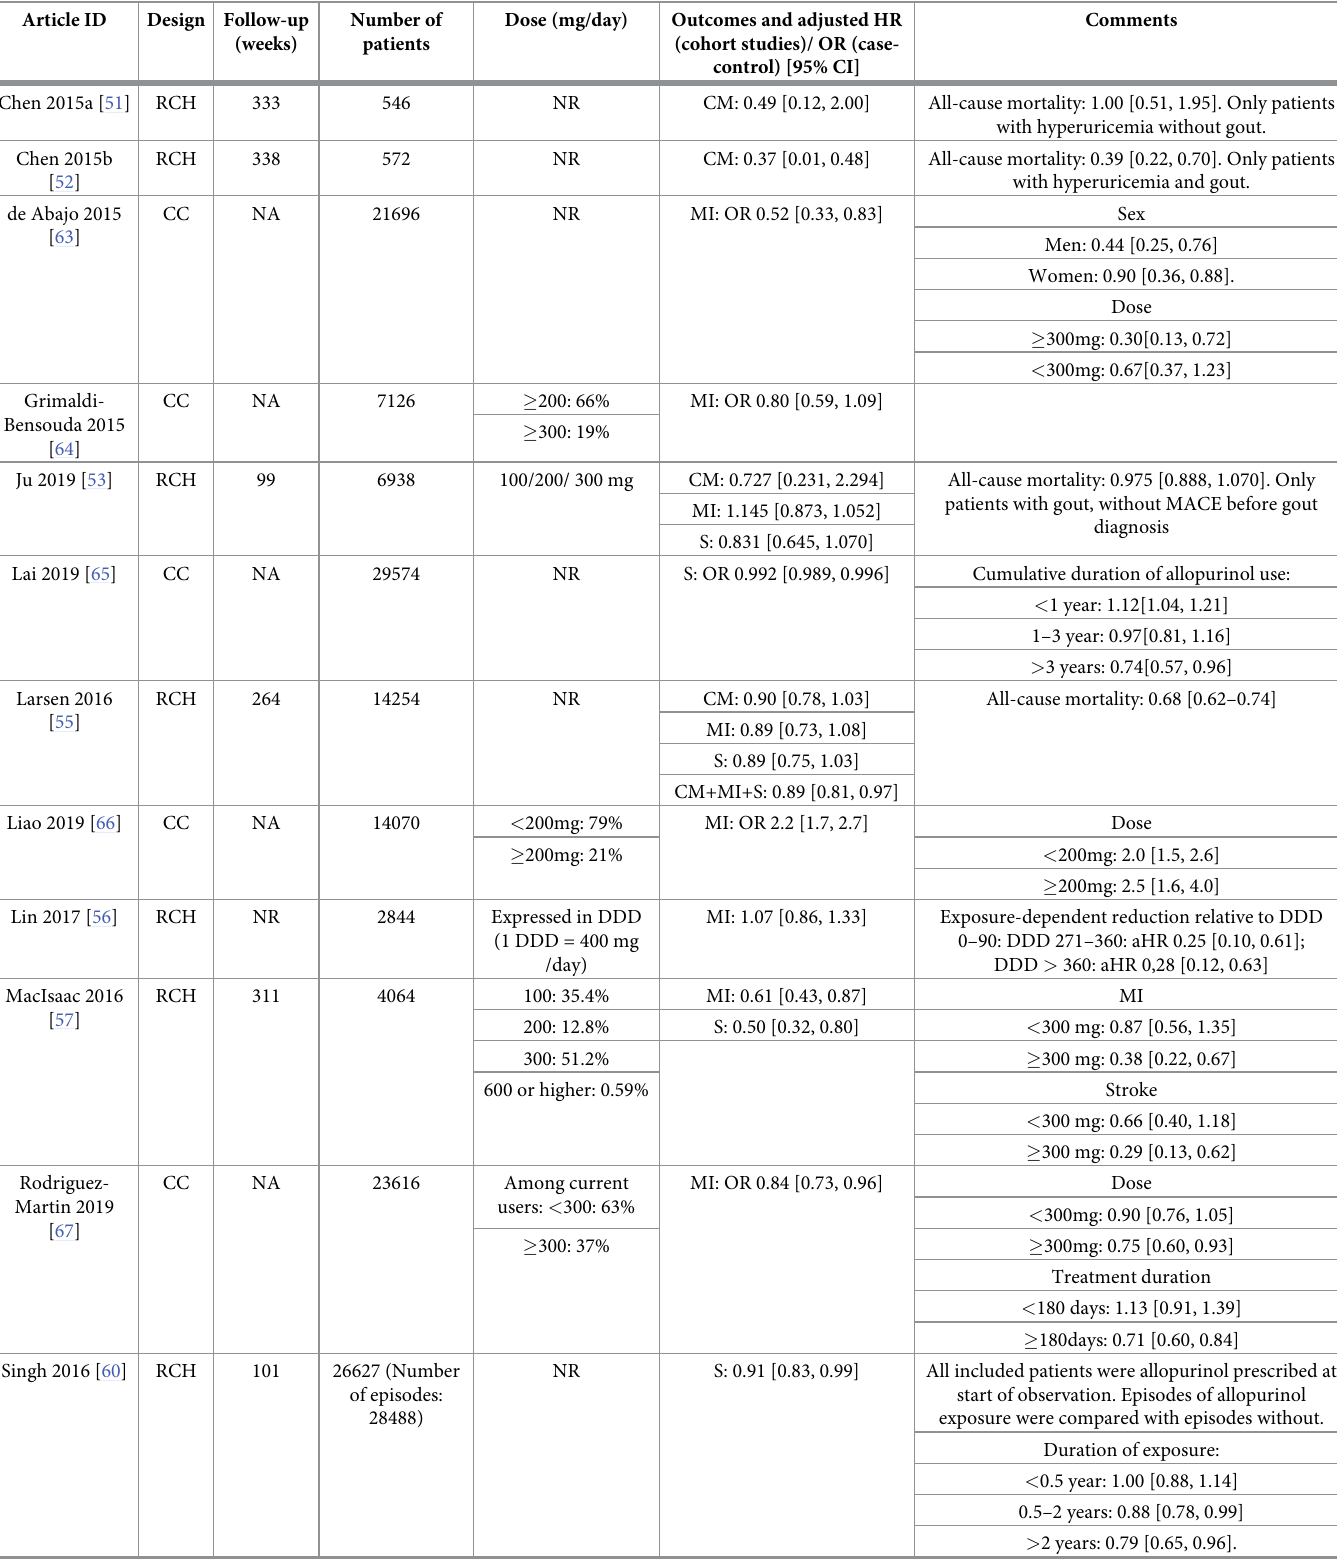
Table 1. Overview of included observational